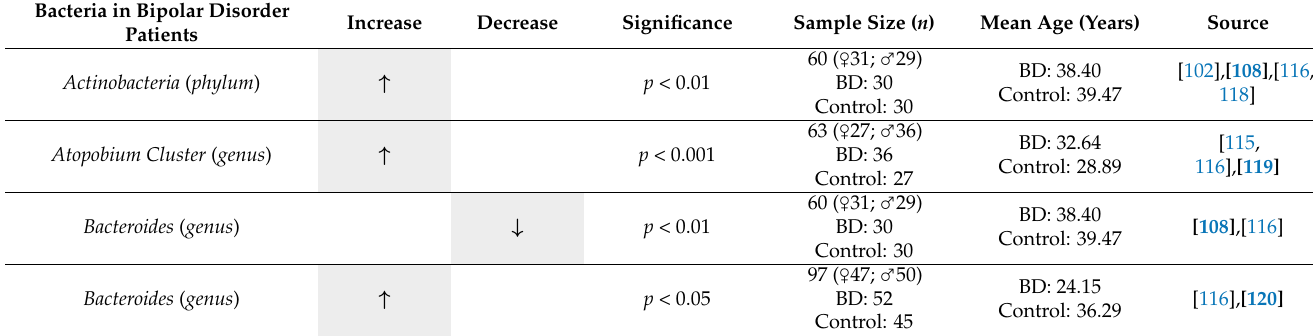
Table 8. Bacteria (with taxonomic level) were found in higher ( ↑ ) or lower ( ↓ ) abundance in patients suffering from bipolar disease (BD). Arrows of the significant results in at least one study are represented with a grey background ( p < 0.05 or LDA values > 2). Empty cells mean that no significant differences could be identified. For the studies’ demographic characteristics, sample size and mean age were included. Sample size numbers are split into females and males for patients and healthy controls. The mean age is given for the patient group and the healthy control group, as a further breakdown for the gender groups was not consistently provided. The relevant source is shown in bold